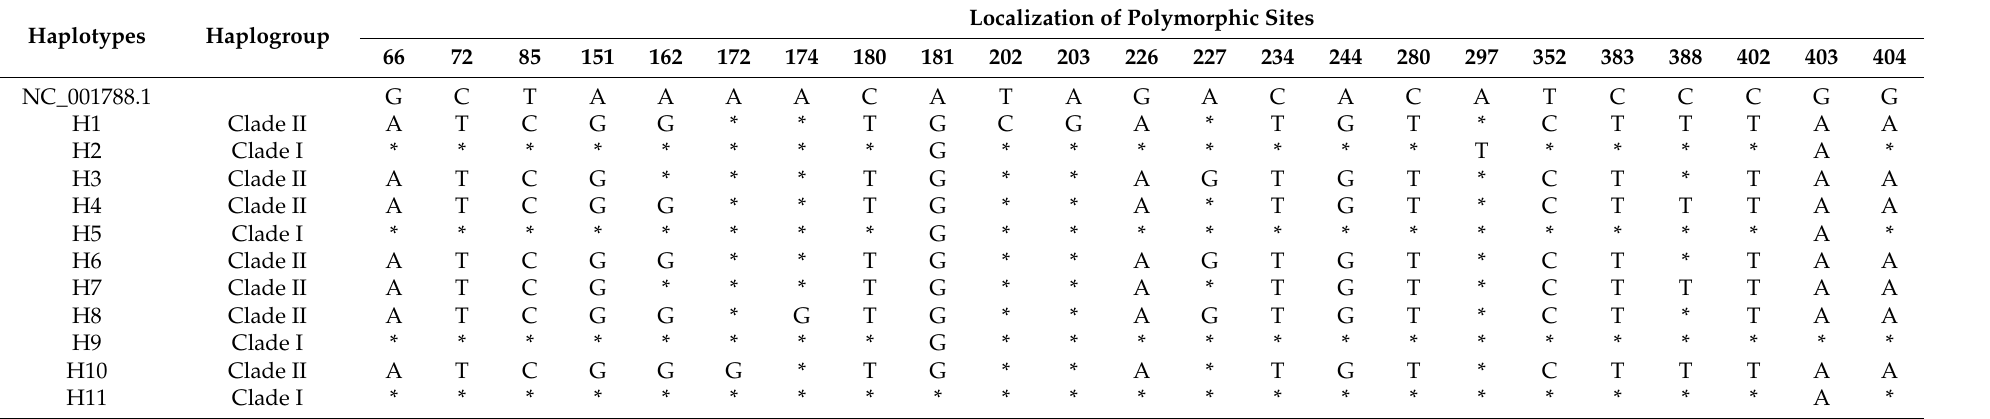
Table 4. Haplotypes and polymorphic sites of the Huaibei Grey donkey